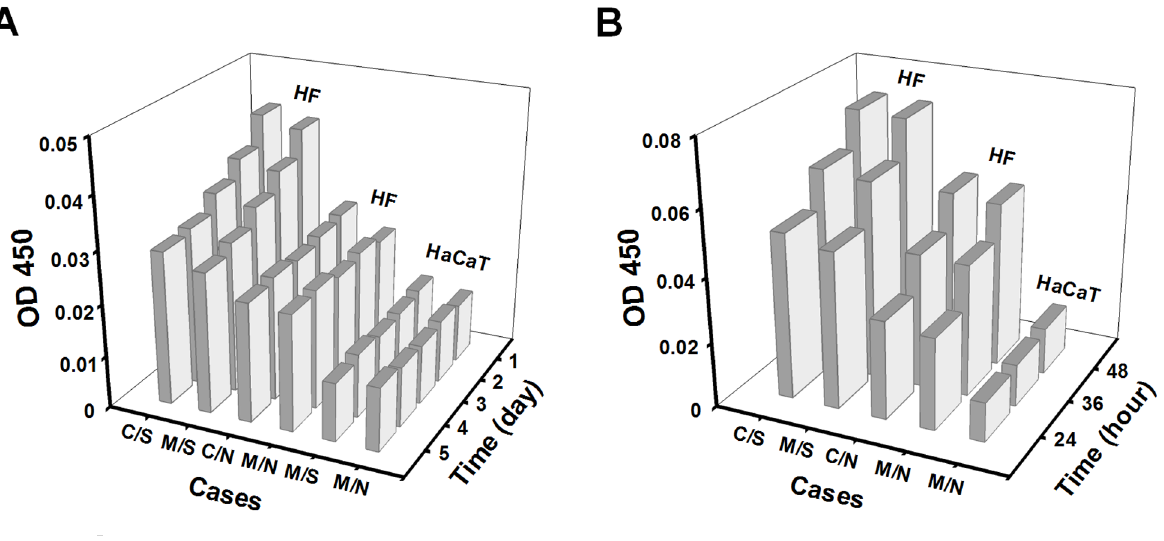
Figure 7. Comparison of content of EGF secretion in the conditional medium using 2D ( A ) or 3D ( B ) assay. Data were collected from at least triplets and presented as the average optical intensity at OD 450 nm at various time points. SD was not presented for the sake of clarity.